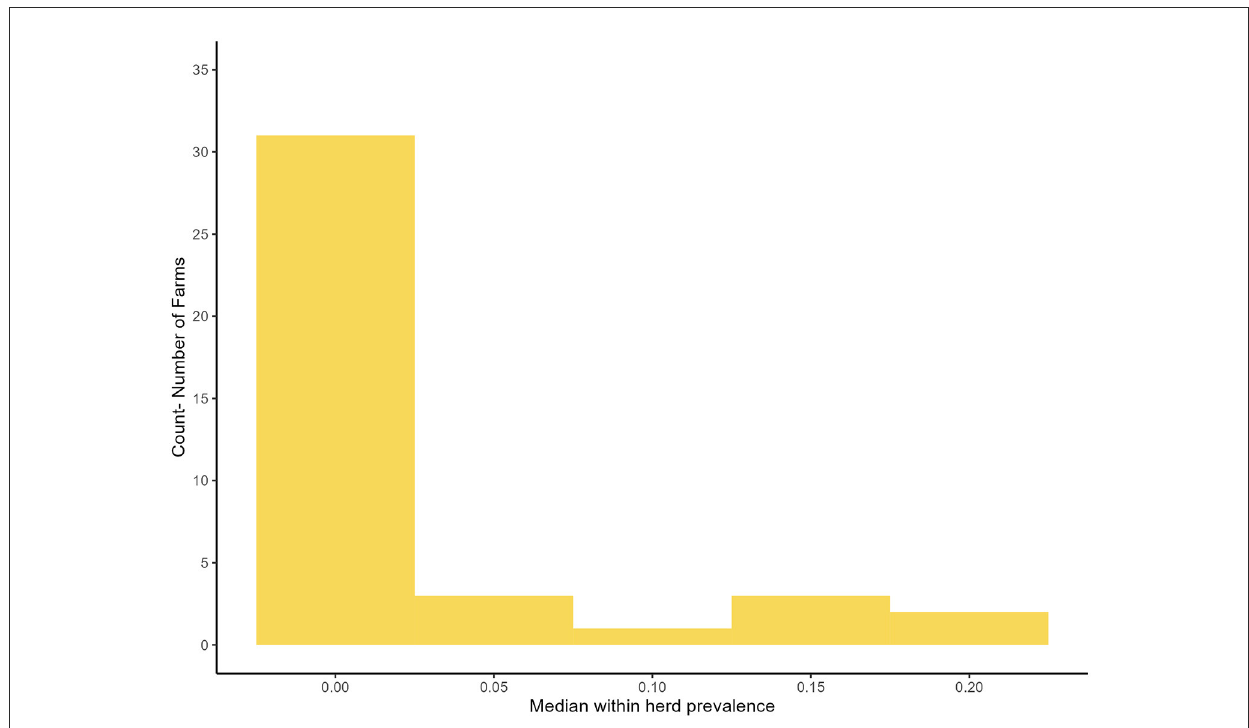
FIGURE4 Distribution of the median, true within herd prevalence as produced by the primary